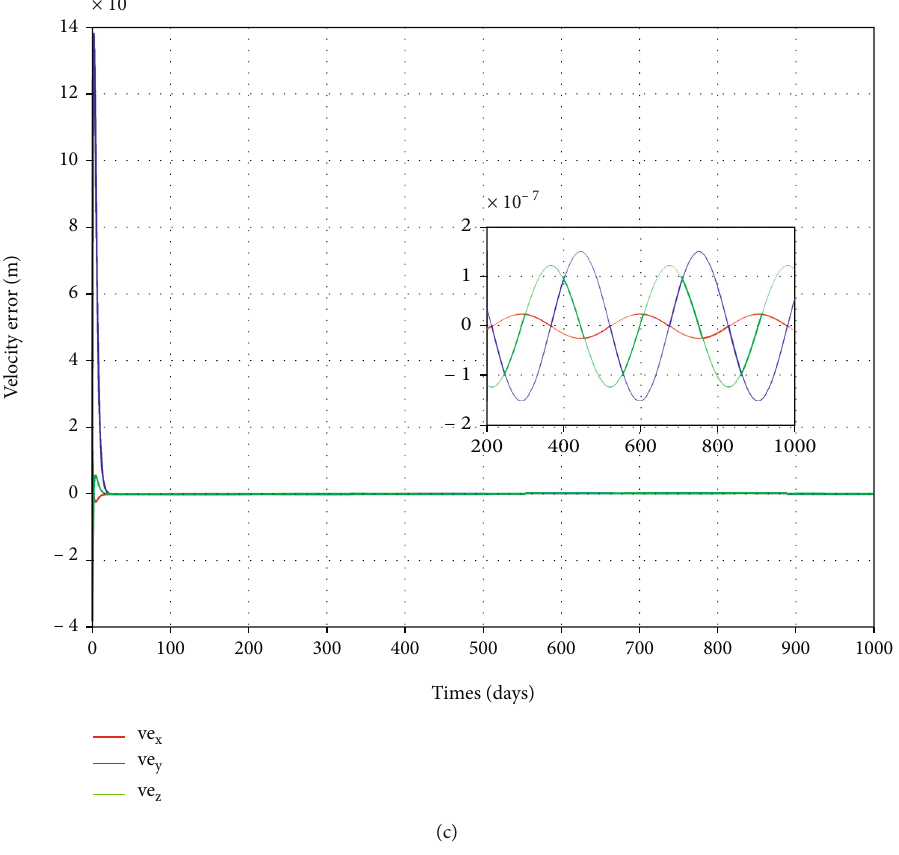
Figure 10: Components of the velocity error (Follower 1) ((a) PID; (b) FTSMC; and (c)